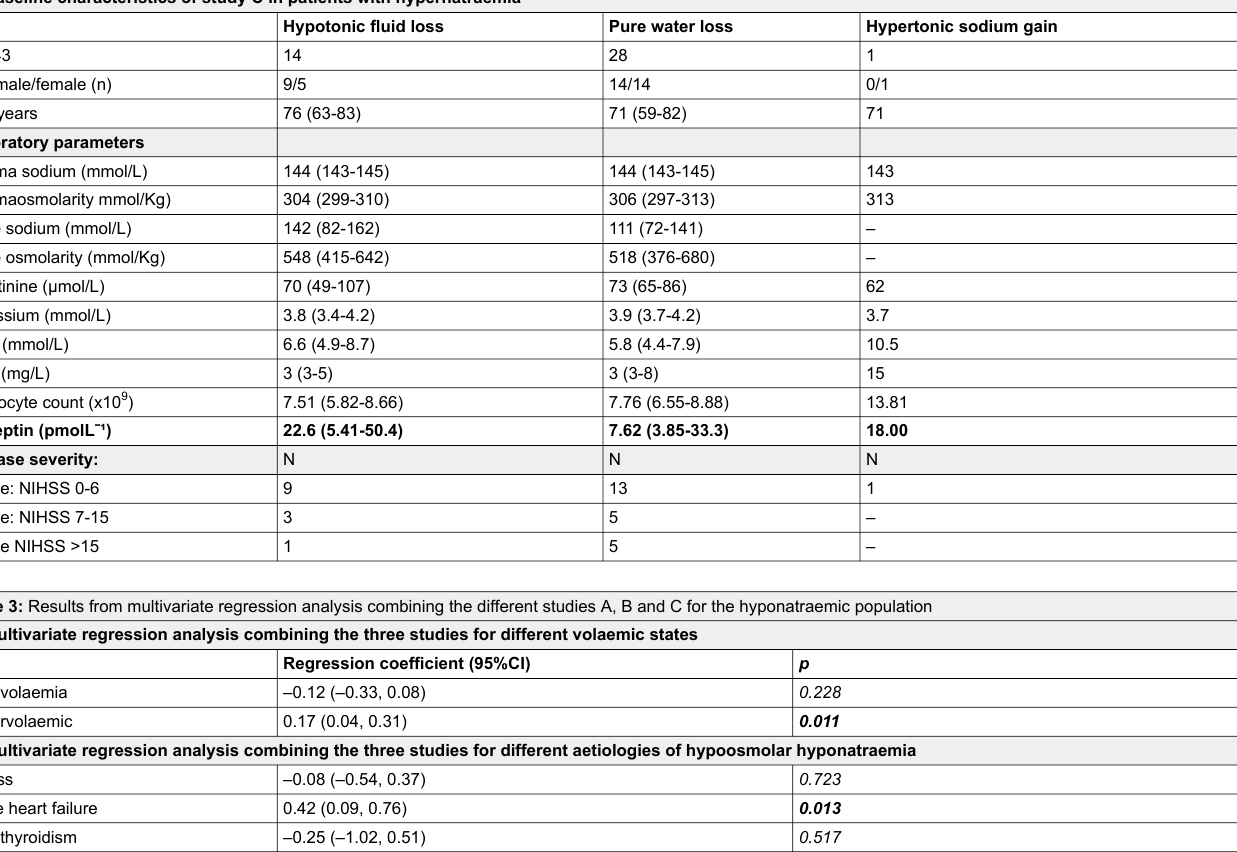
B) Multivariate regression analysis combining the three studies for different aetiologies of hypoosmolar hyponatraemia